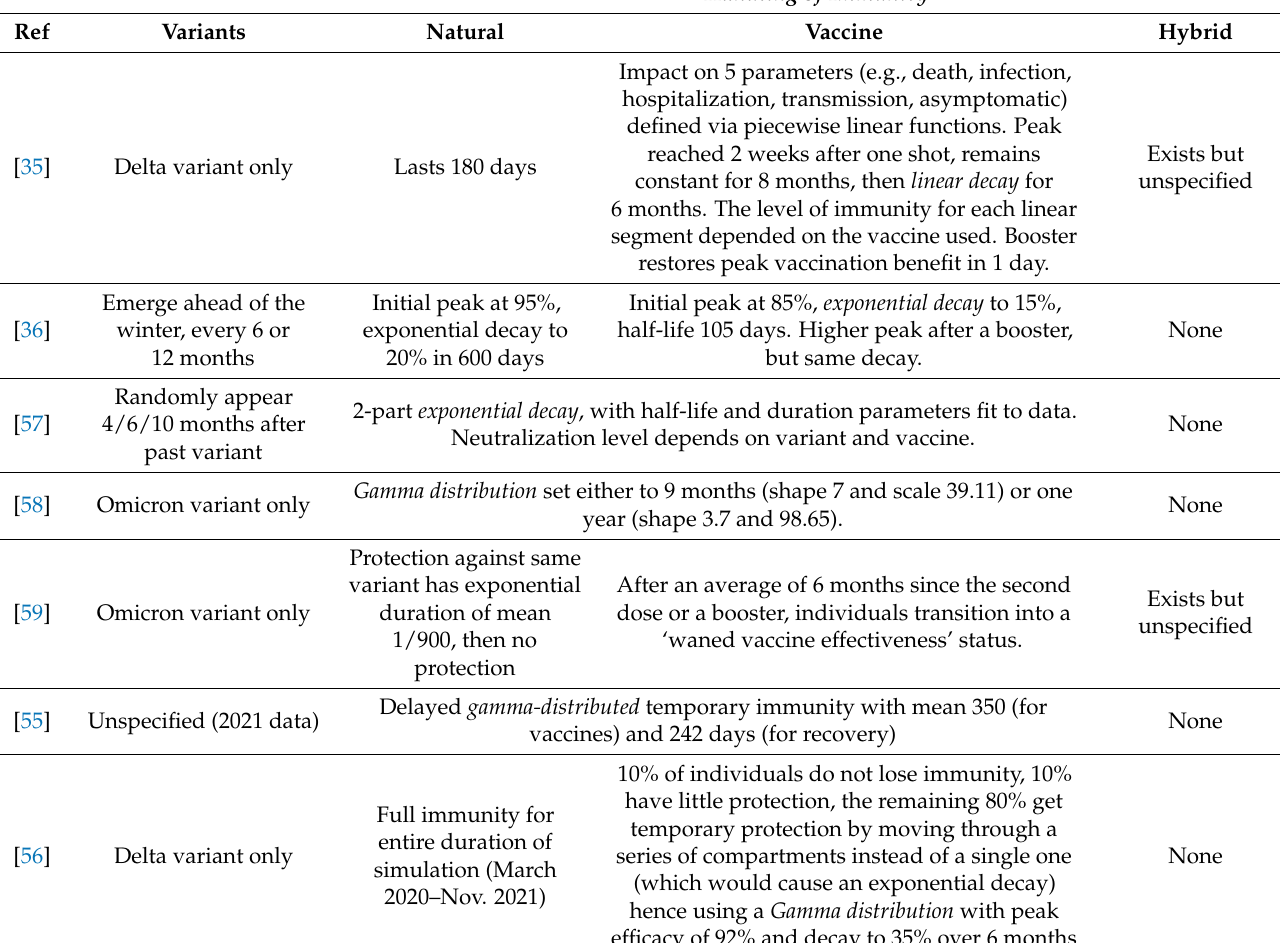
Table 1. Handling of variants and (temporary) immunity in recent COVID-19